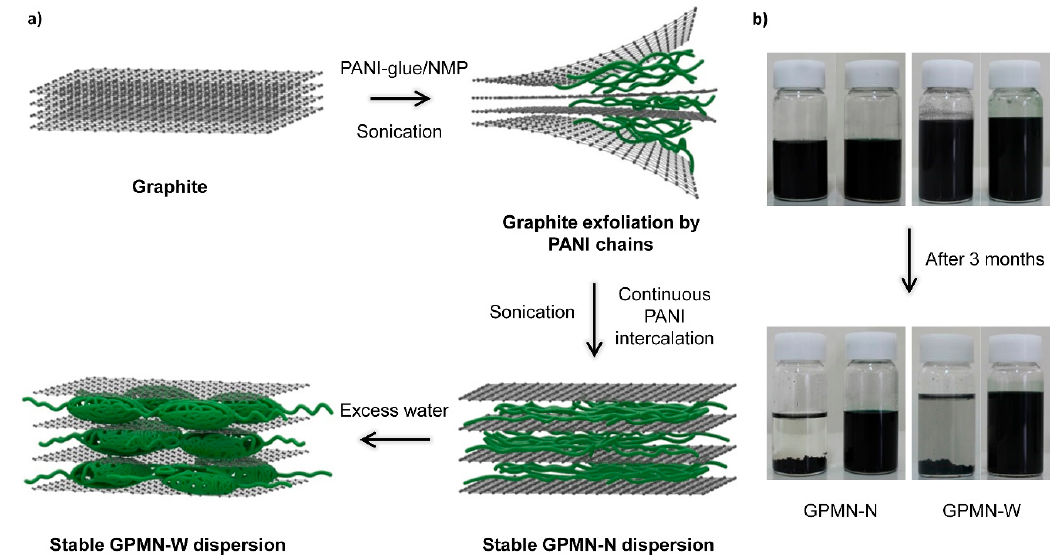
Figure 9. ( a ) Schematic illustration of the formation of graphene/PANI multilayered nanostructures (GPMNs) by direct physical exfoliation of graphite with PANI glue; ( b ) Photographs showing the long-term colloidal stability of the GPMN dispersion solution in the absence (left) and the presence (right) of PANI glue. GPMNs showed outstanding colloidal stability in both N -methyl-2-pyrrolidone (NMP) and water. Reprinted with permission from [45]. Copyright 2015, John Wiley & Sons. Table 8. Representative examples of studies where carbon nanomaterials were incorporated into CPs. Carbon CP Preparation method Details Refs.